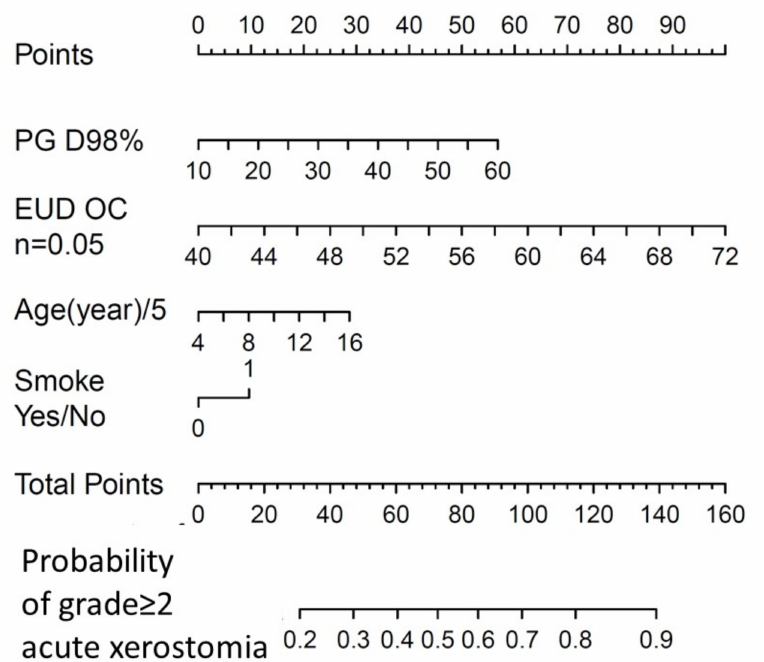
Figure 4. Nomogram for grade ≥ 2 acute salivary dysfunction as derived from the multivariable logistic regression model presented in Table 3. Age is expressed in 5-year units. cPG = combined parotid glands; OC = oral cavity; and EUD = Equivalent Uniform